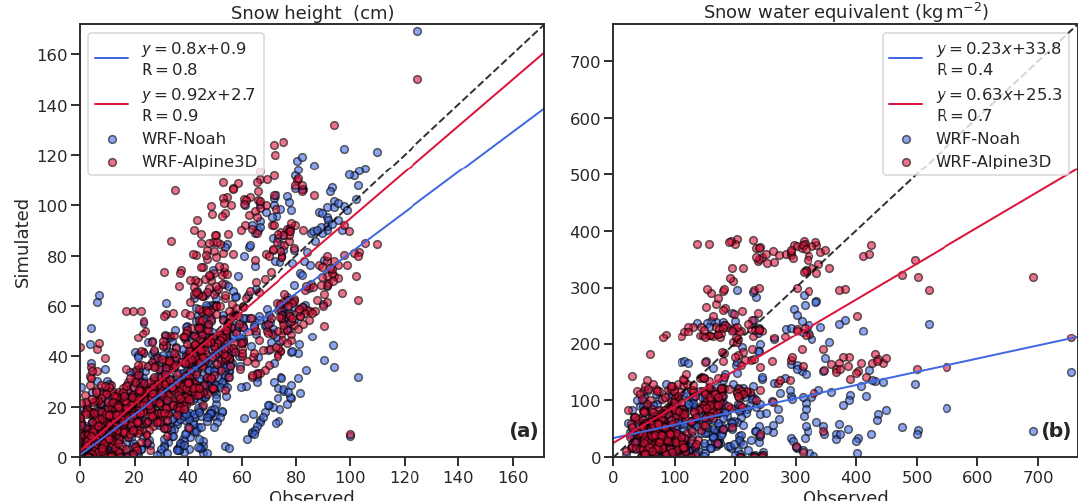
Figure 5. Comparison of simulated and measured daily means of snow height (a) and snow water equivalent (b) averaged for each elevation band shown in Table 2 for the three snow seasons. Blue and red dots indicate WRF–Noah and WRF–Alpine3D, respectively. The blue and red lines represent the best linear fit of WRF–Noah and WRF–Alpine3D